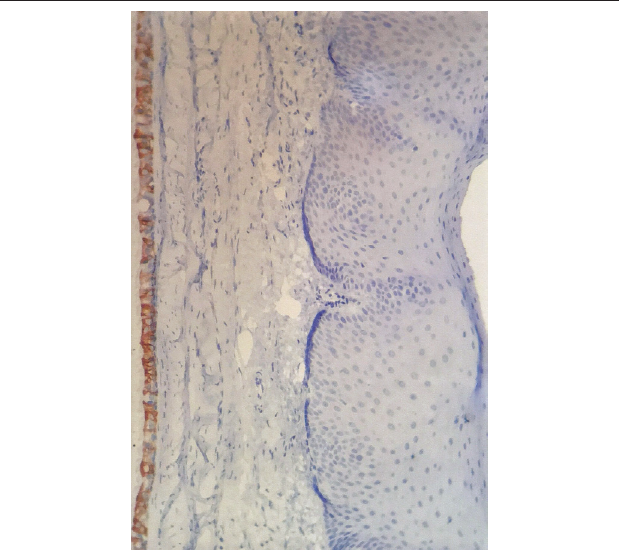
Figura 5 − Perfil imuno-histoquímico do corte da lesão